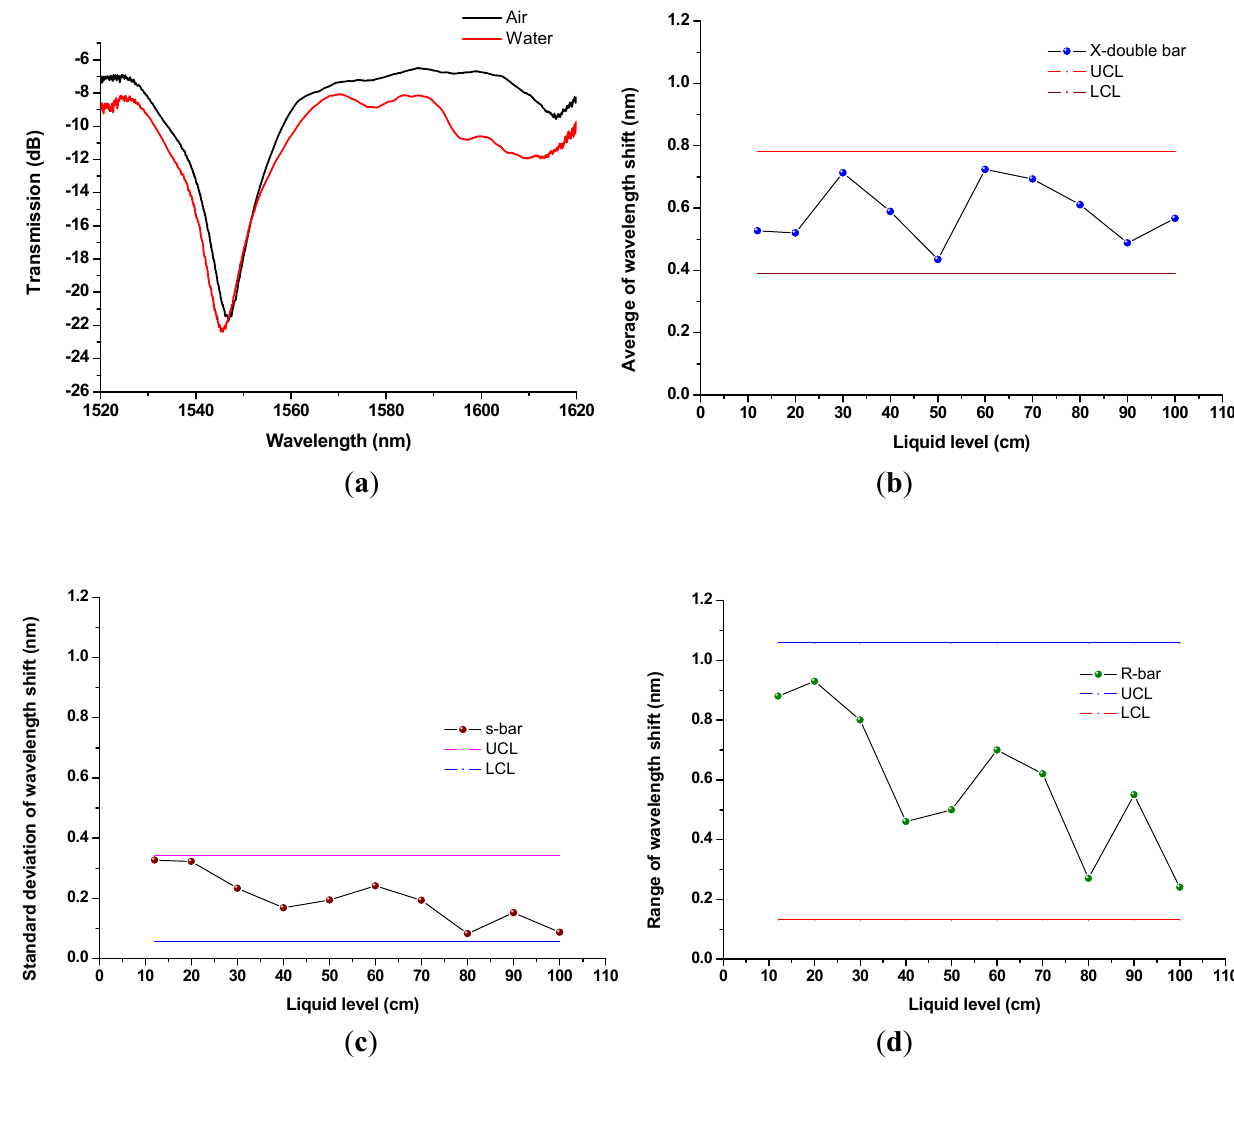
Figure 4. ( a ) The spectra of the mobile liquid level sensor with a 1,546.25-nm resonance wavelength LPFG was immersed in air and in water when liquid level was equal to 10 cm; ( b ) The X-bar chart of wavelength shifts for ten groups of water level experiment; ( c ) The s chart of wavelength shifts for ten groups of water level experiment; ( d ) The R chart of wavelength shifts for ten groups of water level